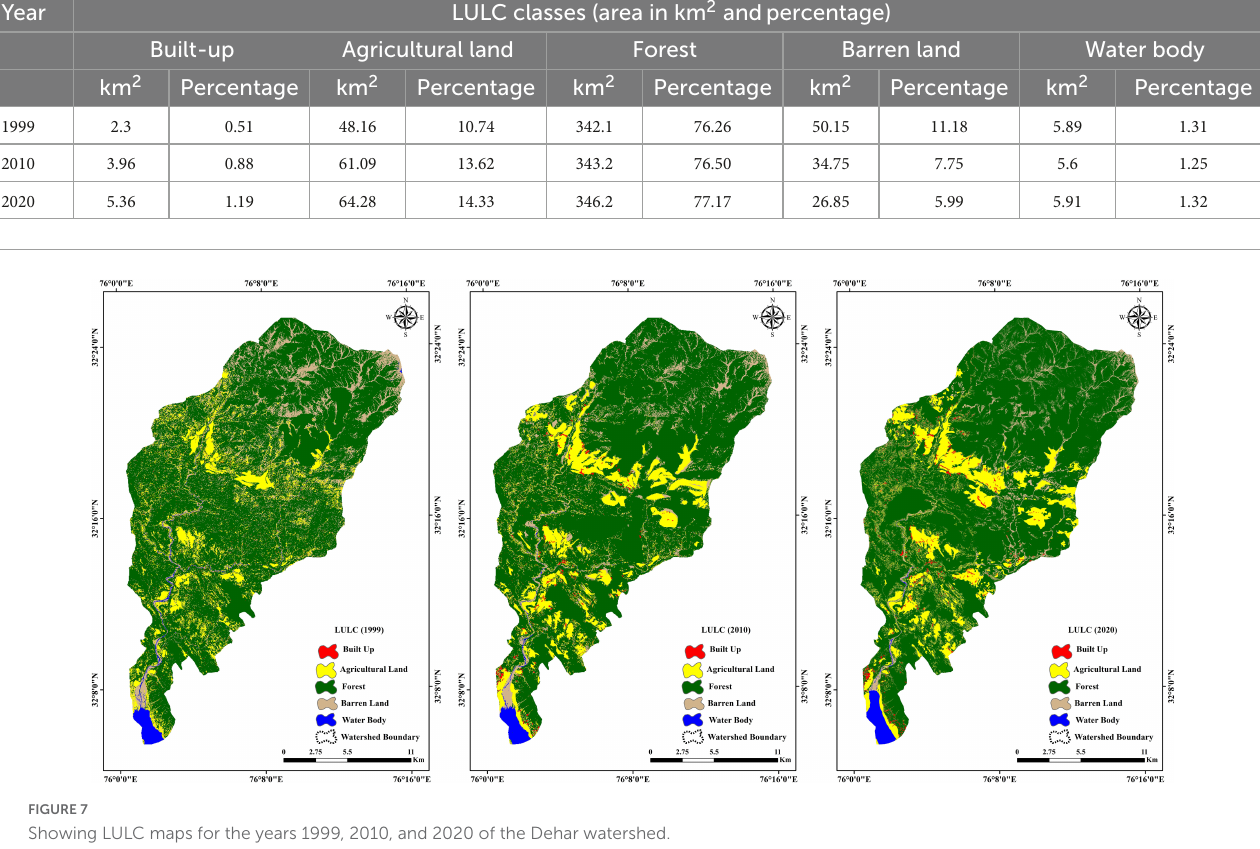
TABLE 4 Area under different LULC classes for the years 1999, 2010, and 2020.